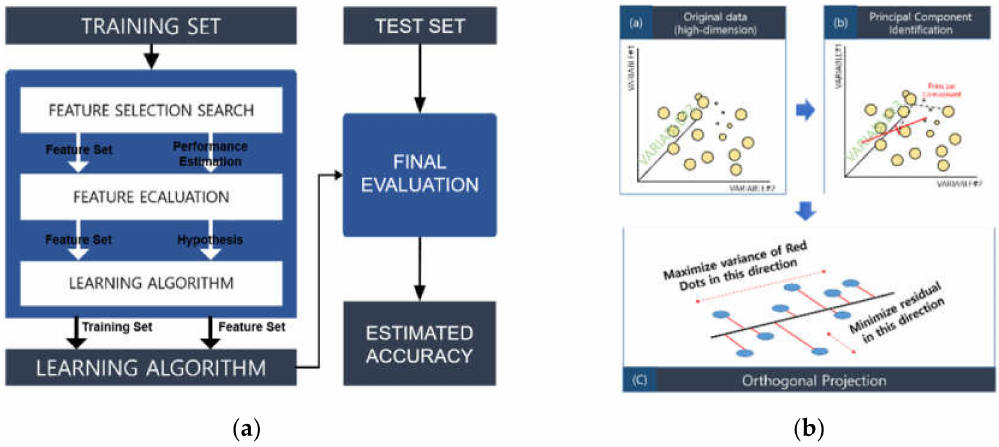
Figure 2. Dimensionality reduction technique. ( a ) Feature selection procedure. ( b ) Principal component analysis